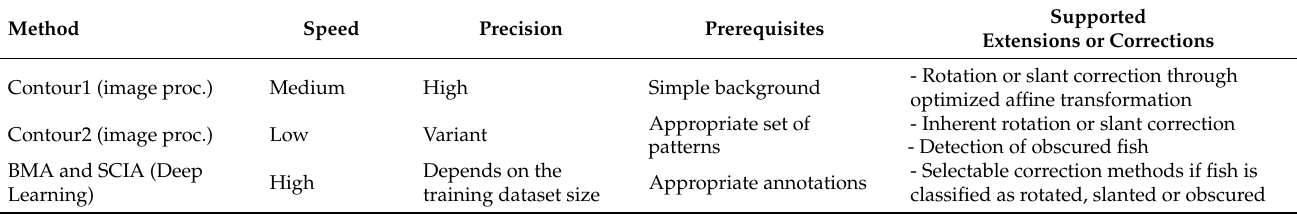
Table 8. Summary of employed method features.